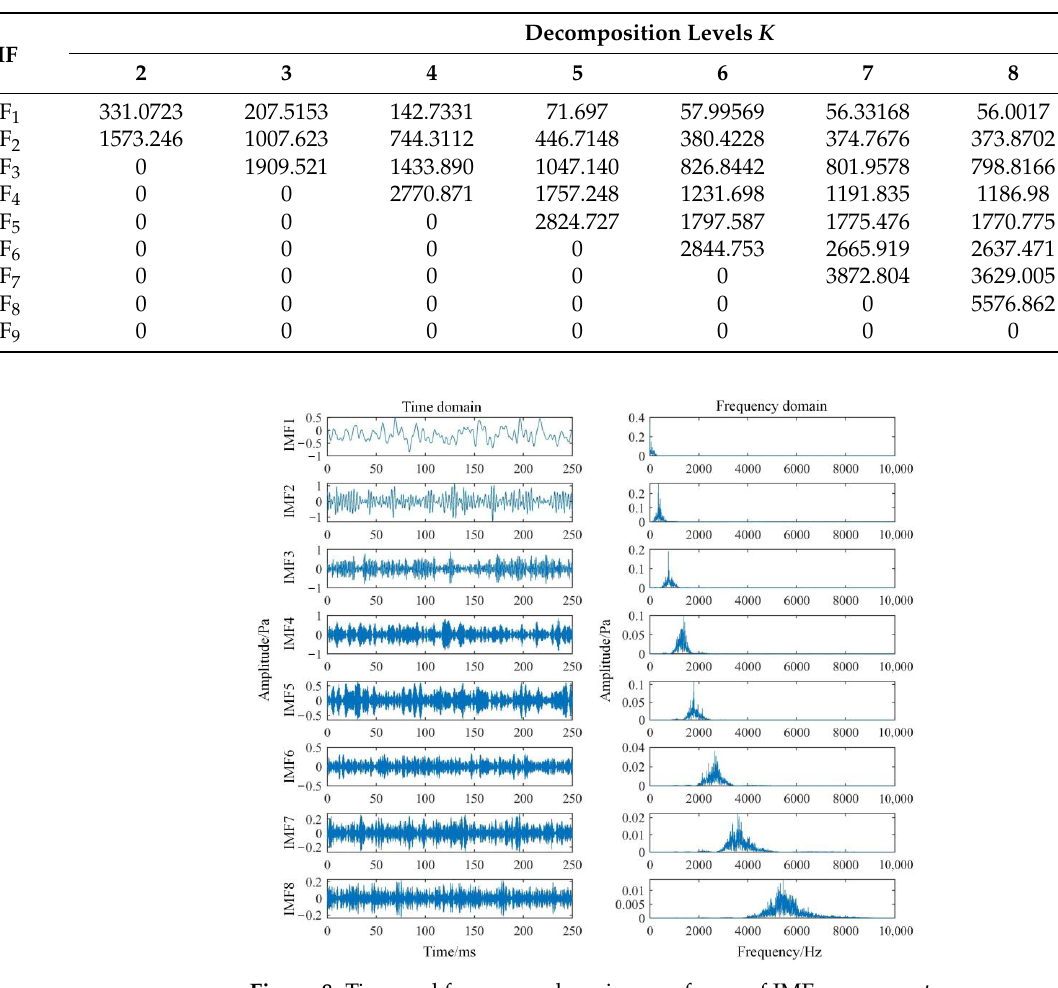
Figure 8. Time and frequency domain waveforms of IMF components.